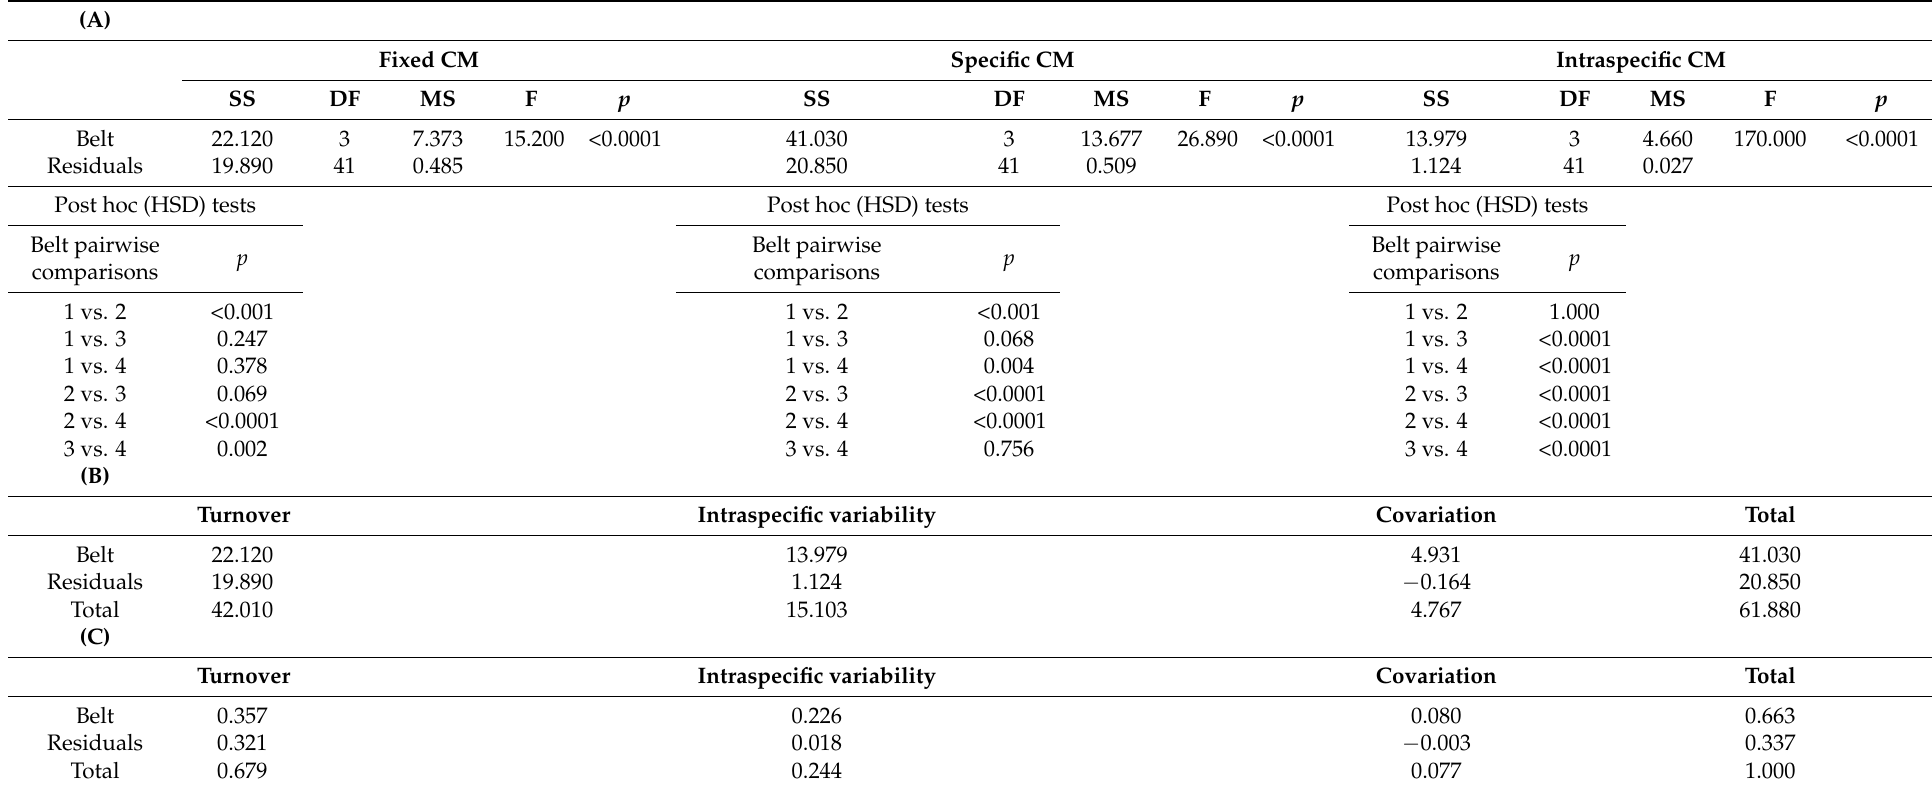
Table 4. Results of ANOVAs for CM of specific leaf area (SLA). ( A ) ‘Fixed’ and ‘specific’ averages and intraspecific variability effect were analyzed separately (one-way ANOVA), followed by post hoc (HSD) tests for pairwise comparisons. ( B ) Variability of individual components of trait variation (turnover, intraspecific and their covariation) between belts. ( C ) Proportions of variability of individual components and their parts explained by elevation (belt). For details, see Table